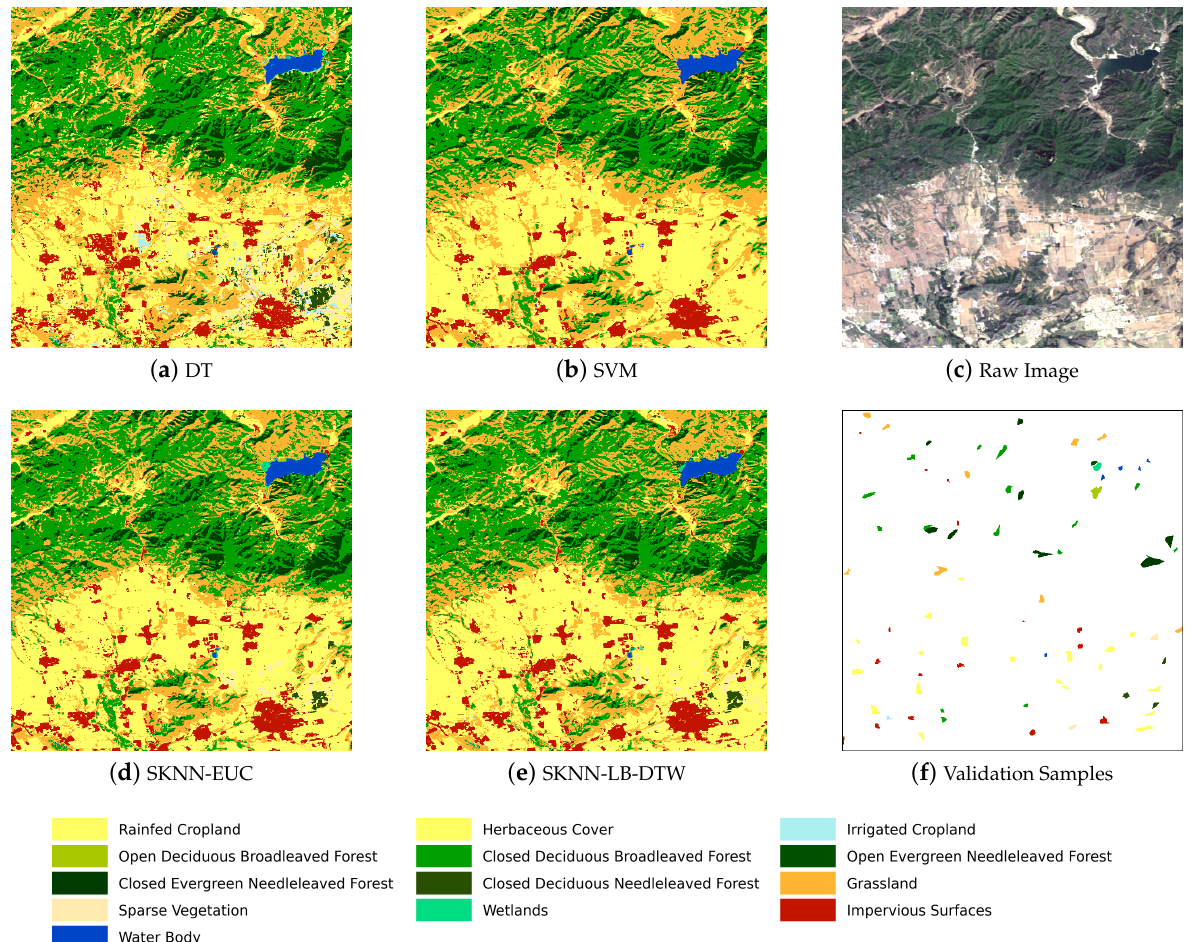
Figure 11. Comparison of classification maps of the third grid with the corresponding validation samples and a reference image.